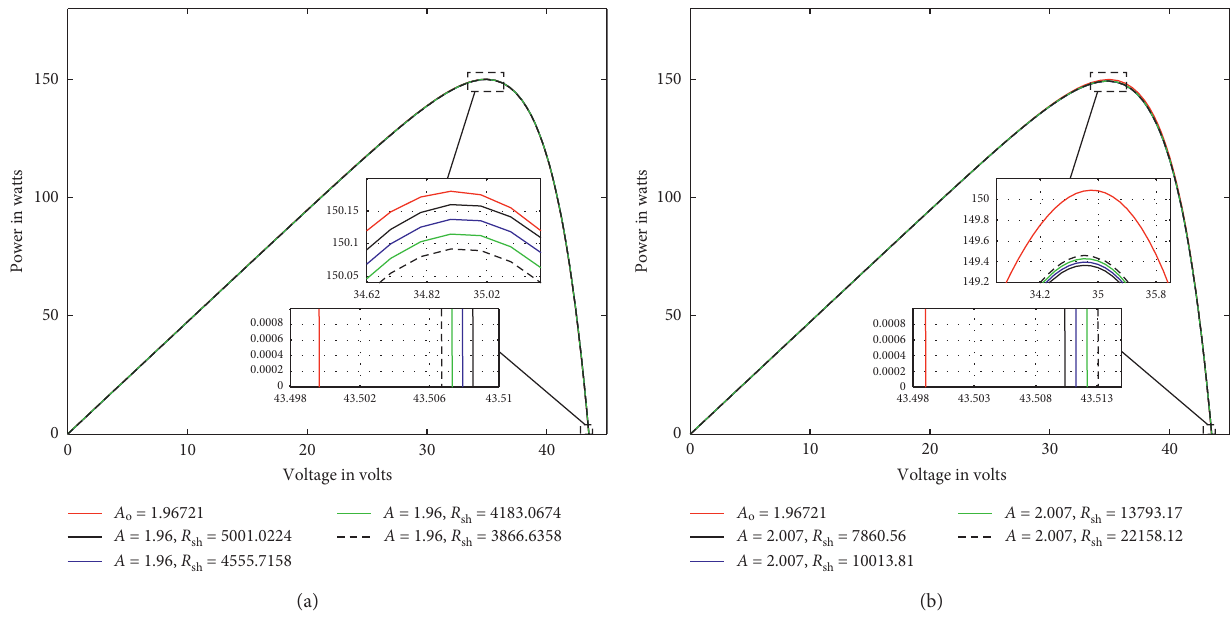
Figure 7: PV curves for BP-SX 150 showing different ( R